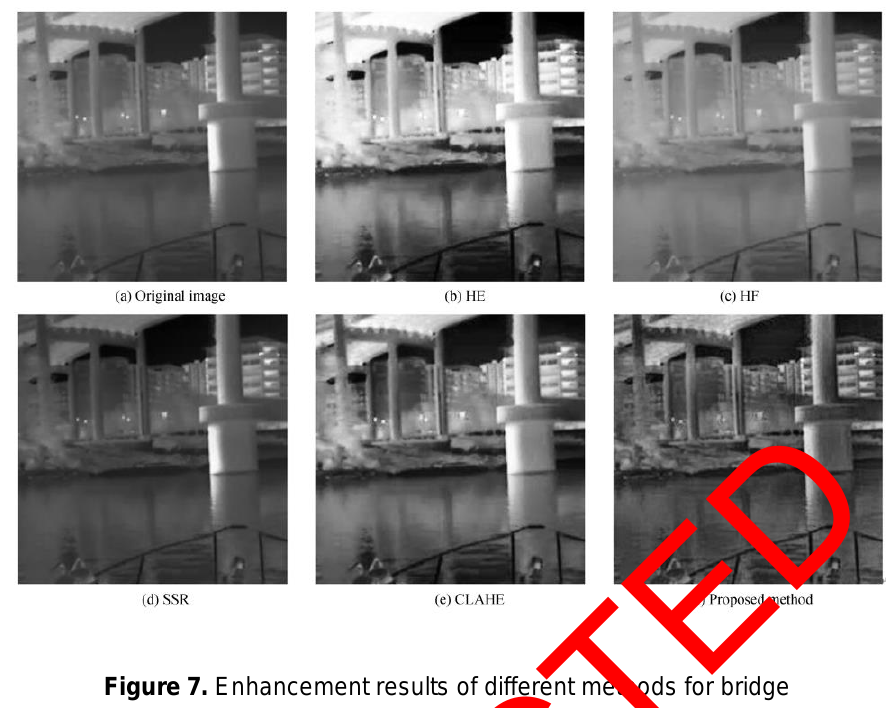
Figure 7. Enhancement results of different methods for bridge